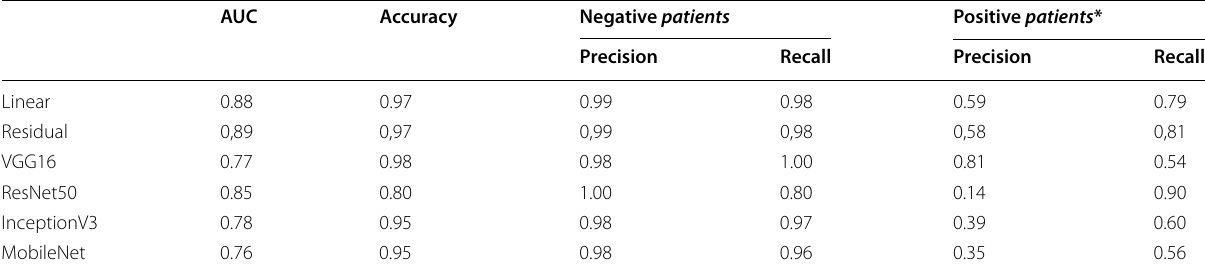
Table 3 Cross‑validated results for automated detection of patients with positive cardiac uptake suggestive for ATTR